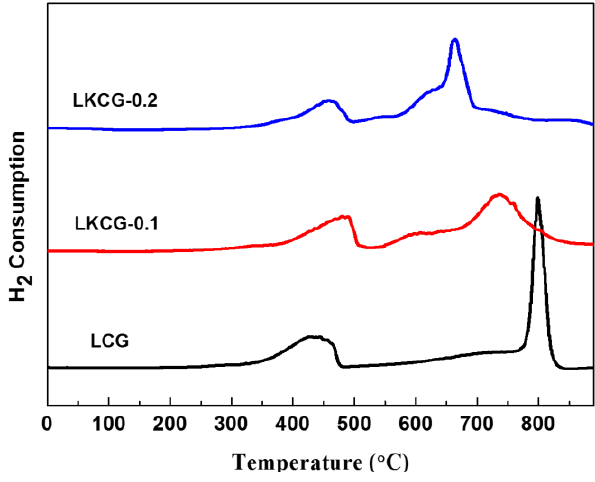
Figure 2. The temperature-programmed reduction (TPR) curves of catalysts after calcination.